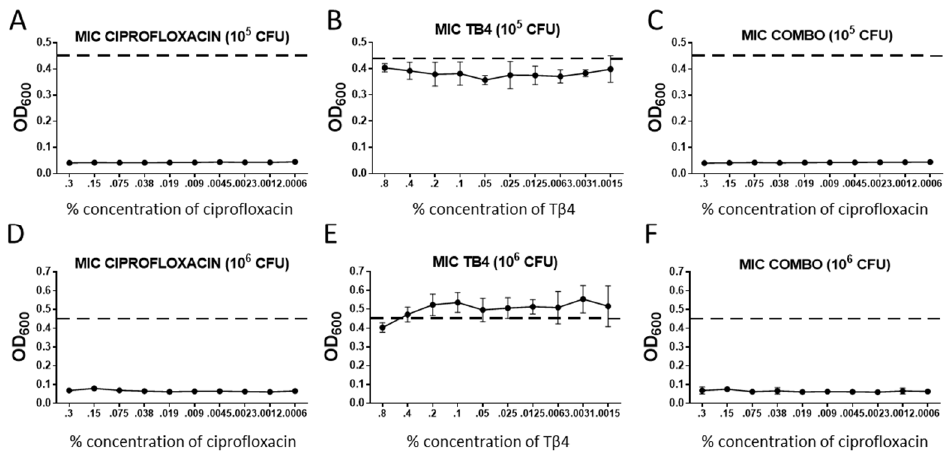
Figure 1. Results from MIC assays represented as OD 600 readings + SD for ( A , D ) ciprofloxacin; ( B , E ) thymosin beta 4 (T β 4); ( C , F ) combination T β 4 + ciprofloxacin, measured at varying concentrations. Each group was run for a minimum inhibitory concentration based on 10 5 ( A – C ) and 10 6 ( D – F ) CFU / mL Pseudomonas aeruginosa (PA). Concentrations are denoted along the x -axis. For the combination treatment, cipro concentrations are along the x -axis and T β 4 was used at 0.1%. Positive controls are denoted by the dashed line. n = 6 / group /